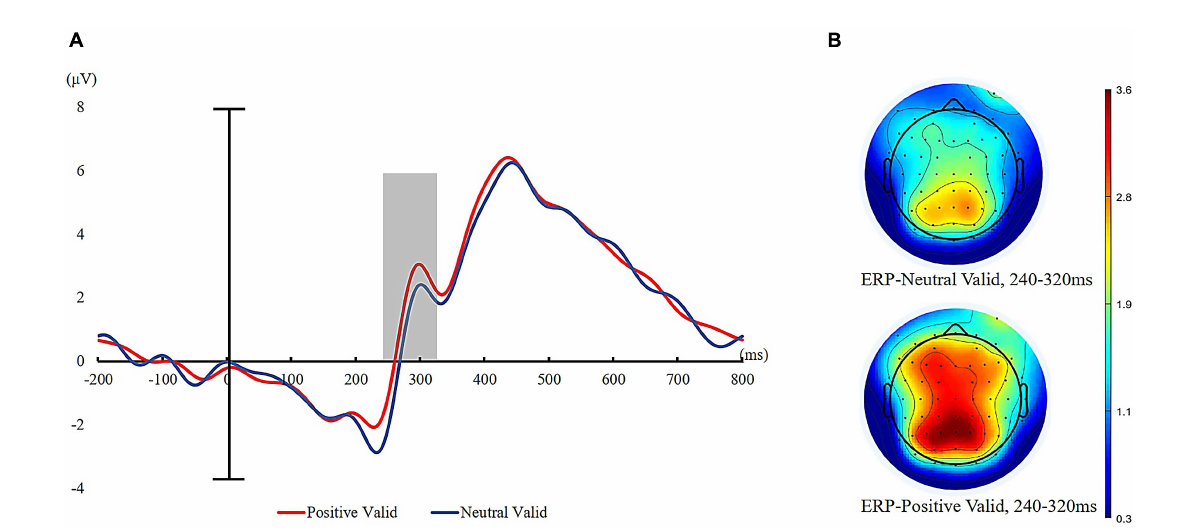
FIGURE5 ERPs time-locked to visual target presentation for valid trials. (A) Grand average waveforms of P300 to valid targets at five sites (CPz, CP1, CP2, CP3, and CP4) for positive auditory cues and neutral auditory cues (positive valid = red line and neutral valid = blue line). (B) Topographic maps to visual targets presentation (240–320 ms after the onset of visual